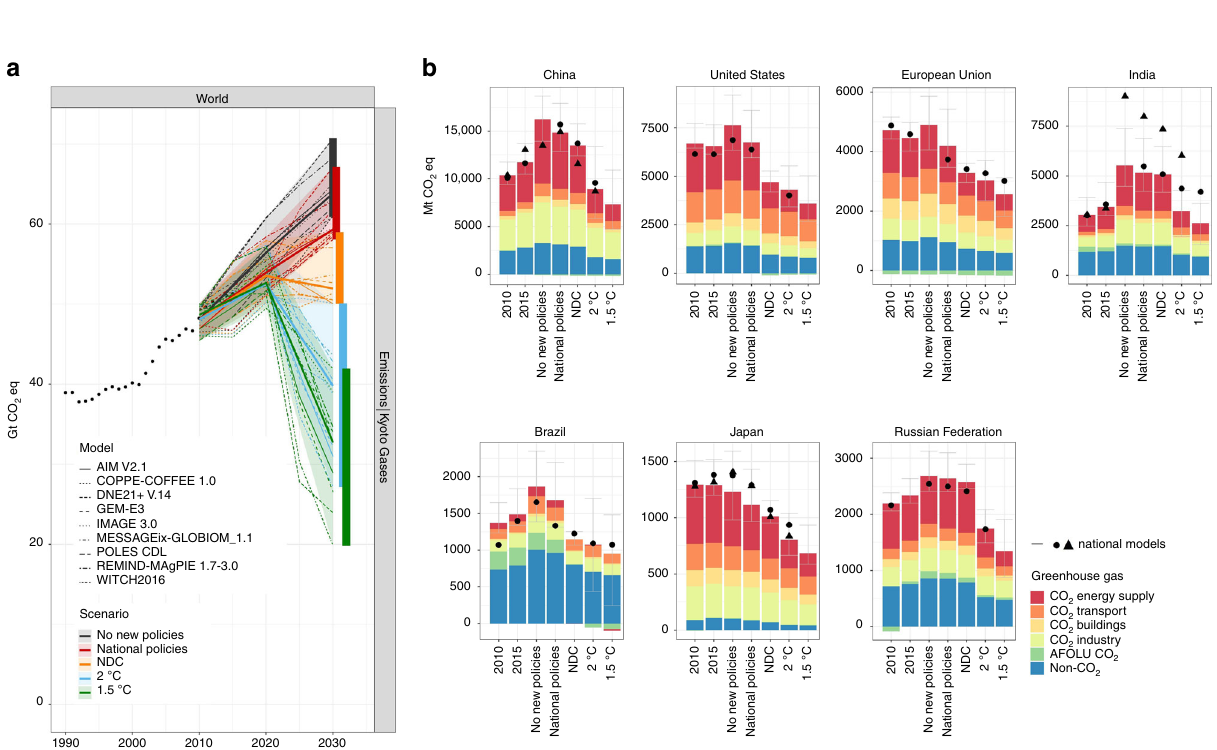
Fig. 1 Greenhouse gas emissions on a global level and seven large countries under different scenarios. a Global greenhouse gas emissions for total greenhouse gases (in GtCO 2 eq) and nine integrated assessment models between 2010 and 2030. b Average greenhouse gas emissions (in MtCO 2 eq) of all models by 2010, 2015 and 2030 for CO 2 emissions per sector and total non-CO 2 emissions (blue), including the 10th – 90th percentile ranges for total greenhouse gas emissions of the multi-model ensemble (error bars). CO 2 emissions have been separated into those related to energy supply (red), transport (dark orange), buildings (light orange), industry (yellow) and AFOLU (agriculture, afforestation, forestry and land-use change) (green). National models are China-TIMES and IPAC for China, GCAM-USA for the United States, PRIMES for the EU, AIM India and India MARKAL for India, RU-TIMES for the Russian Federation, BLUES for Brazil and AIM/Enduse and DNE21 + for Japan. For both panels, CO 2 equivalent greenhouse gases have been calculated using the 100-year Global Warming Potential from the IPCC Fourth Assessment Report. The data is available in the source